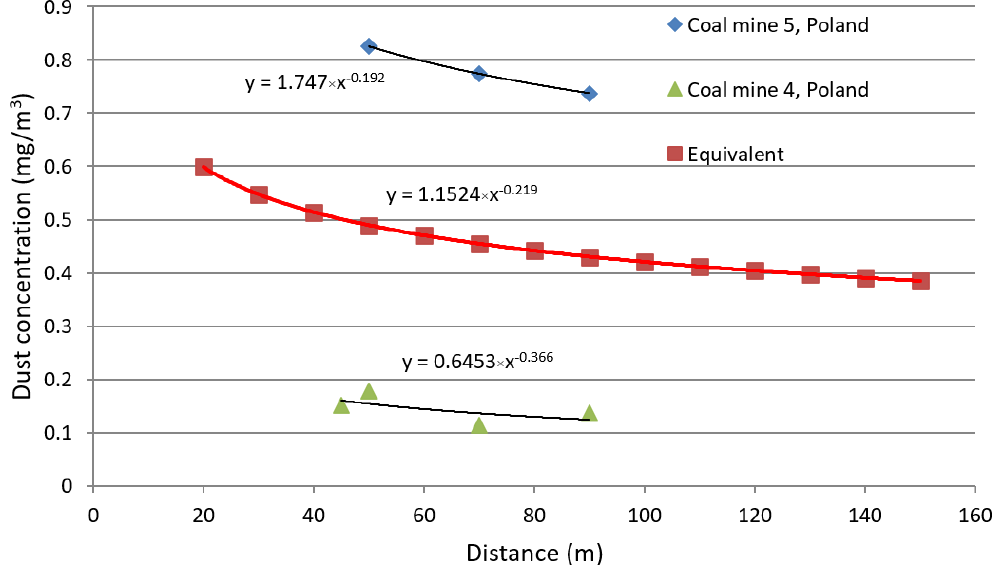
Figure 20. Equivalent characteristics of PM2.5 concentration (measured with an IPSQ analyzer), depending on the distance from the dust source, were determined on the basis of dust tests in two coal faces.